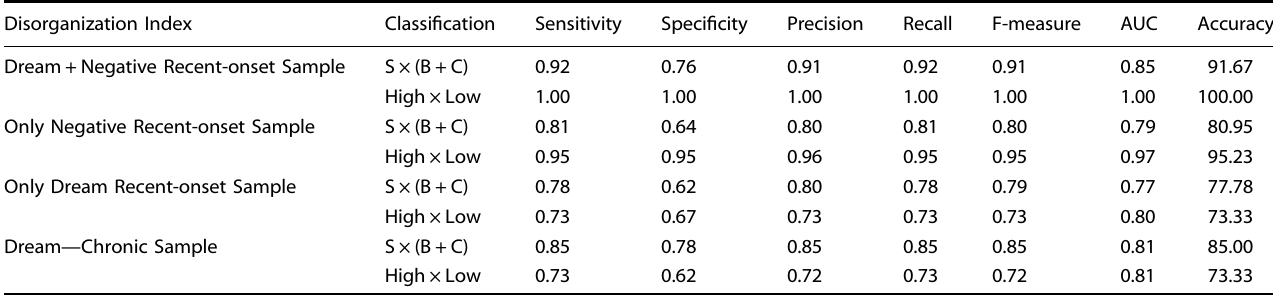
Table 2. Classi fi cation quality of sorting Schizophrenia patients from others subjects, or sorting between low and high negative symptom severity, using the Disorganization Index obtained from dream + negative image reports, negative image reports, or dream reports